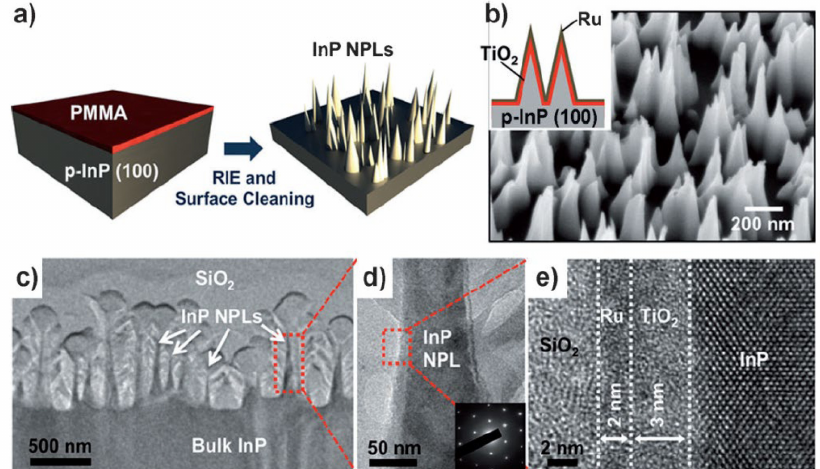
Figure 12. ( a ) Process flow for fabrication of InP nanopillar arrays. ( b ) SEM image of the resulting NPL arrays. Inset shows the schematic of a PEC cell made of p-InP NPLs, a TiO 2 passivation layer (thickness, 3–5 nm), and the Ru cocatalyst (thickness, ca. 2 nm). ( c – e ) TEM images of the p-InP NPLs coated with TiO 2 /Ru layers. The inset in ( d ) shows diffraction patterns confirming the crystalline structure of InP NPLs. Reproduced with permission from [162]. Copyright WILEY-VCH Verlag GmbH & Co. KGaA, Weinheim,